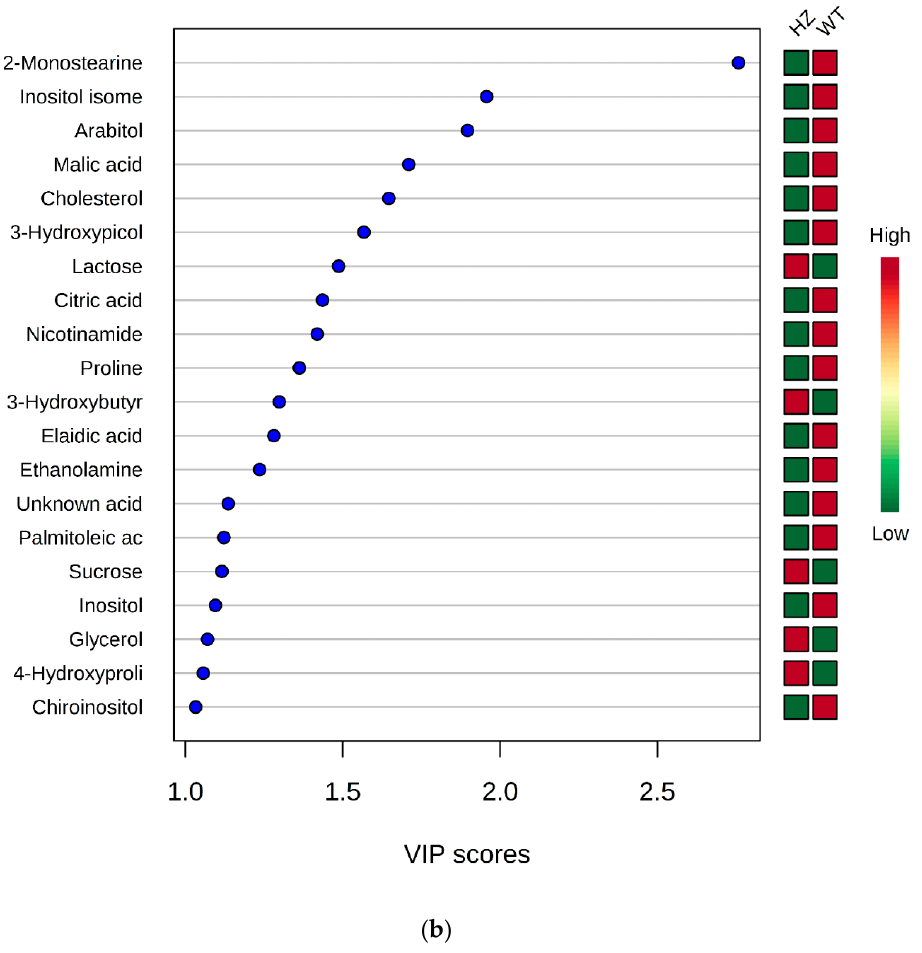
Figure 1. PLS-DA analysis of WT vs. HZ. ( a ) Two-dimensional (2D) score plot, and ( b ) the corresponding VIP score plot (score > 1.0).